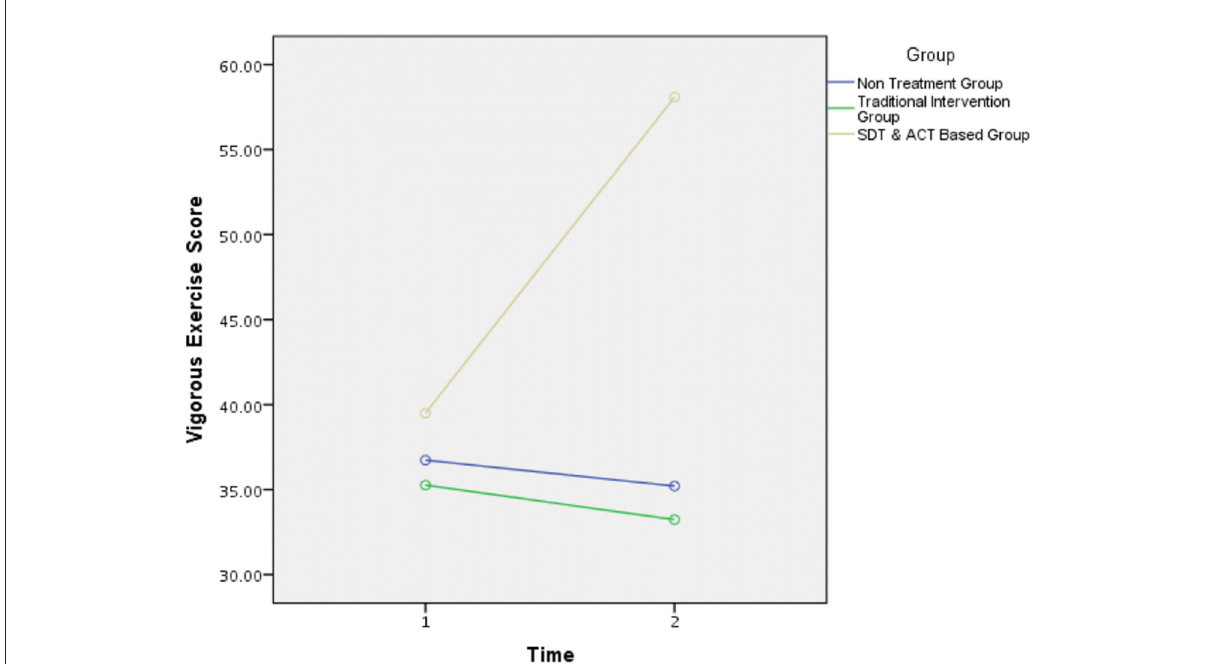
FIGURE3 Vigorous exercise score. The three intervention groups displayed a similar level of engagement in intense physical activity before the intervention (i.e., time 1). Following the intervention (i.e., time 2), SDT and ACT-based intervention group demonstrated a significant increase in vigorous exercise score. However, the two control groups (traditional intervention group and non-treatment group) did not show significant differences between the two-time measurements in this